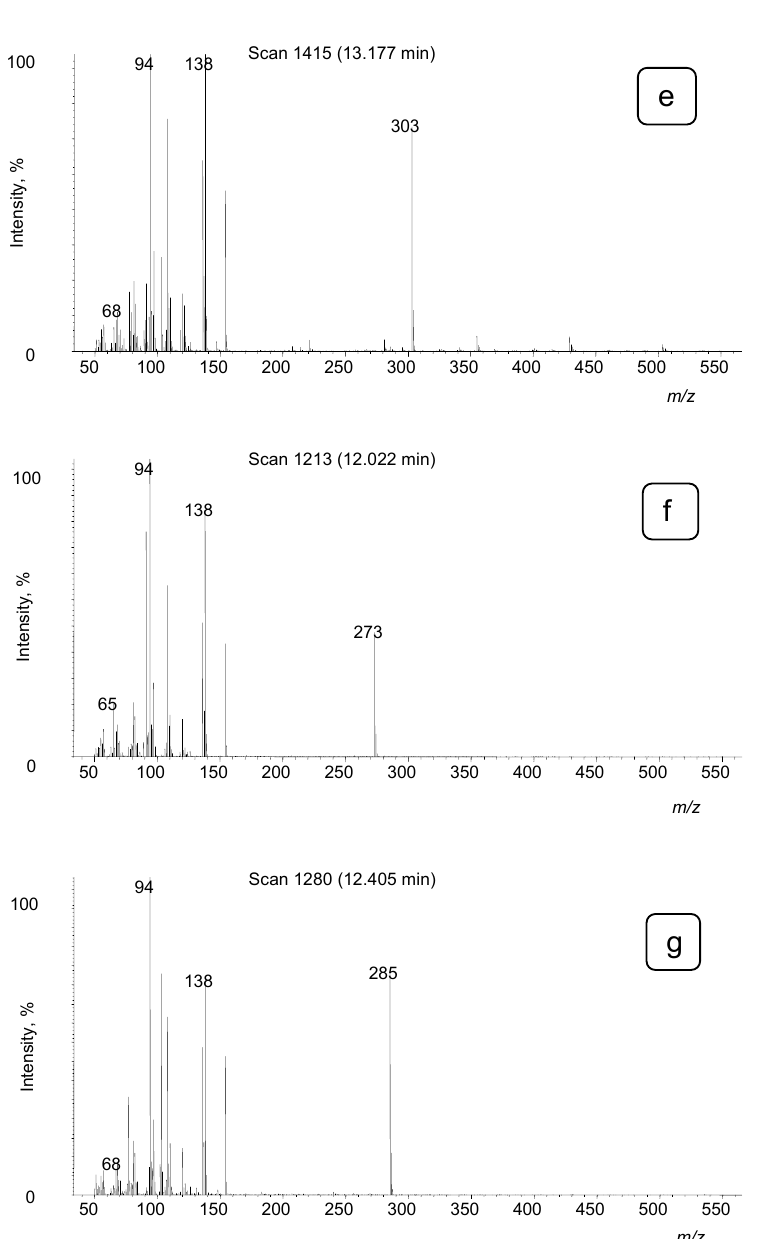
Figure 4. Mass spectra of atropine, scopolamine and their main products of thermolysis. Atropine ( a ), 3-phenylacetoxytropane (atropine-CH 2 O) ( b ), apoatropine (atropine-H 2 O) ( c ), tropine ( d ), scopolamine ( e ), 3-phenylacetoxyscopine (scopolamine-CH 2 O) ( f ), aposcopolamine (scopolamine-H 2 O) ( g ). Table 1. Influence of inlet temperature and concentration on the ratio between atropine and its degradation products in ethyl acetate presented as percentage of a sum of areas. Inlet